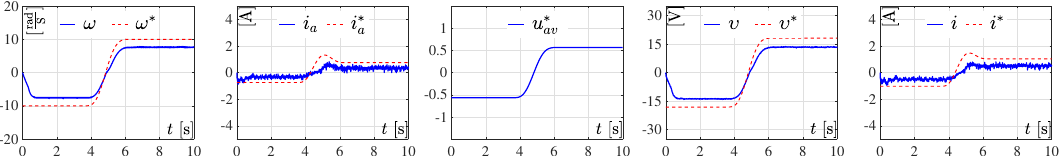
Figure 11. Experimental results for a Bézier-type trajectory. The results of the measured variables are ω , i a , υ , i , and the results of the reference variables are ω ∗ , i ∗ a , u ∗ av , υ ∗ , i ∗ . Experiment 2